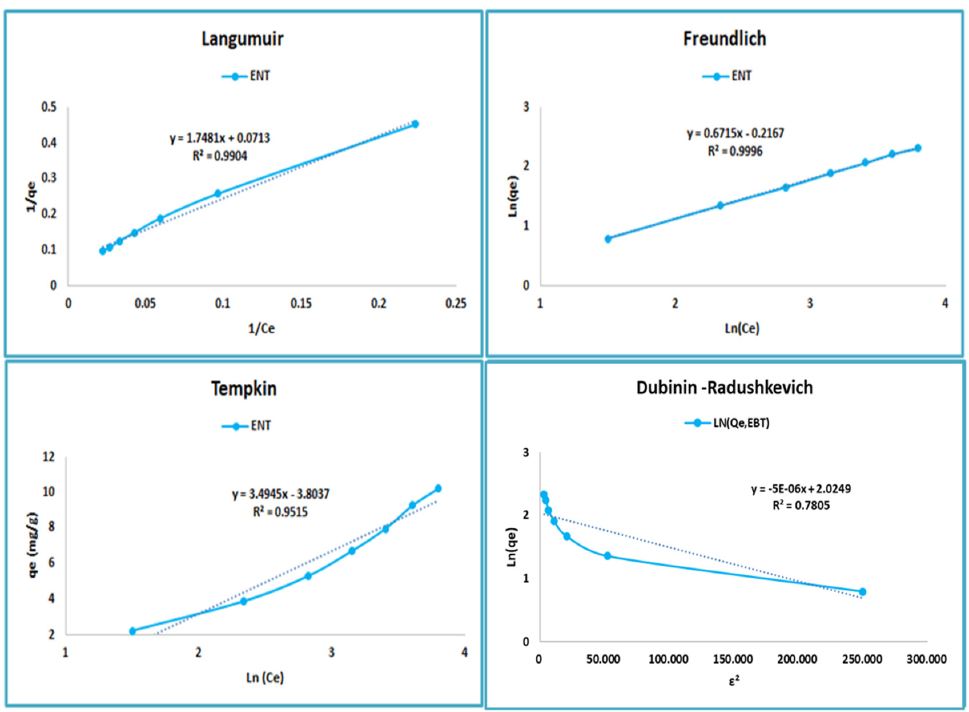
Figure 13. Langmuir, Freundlich, Temkin, and Dubinin–Radushkevich isotherm models curves of activated carbon of cannabis adsorption towards BET dye.